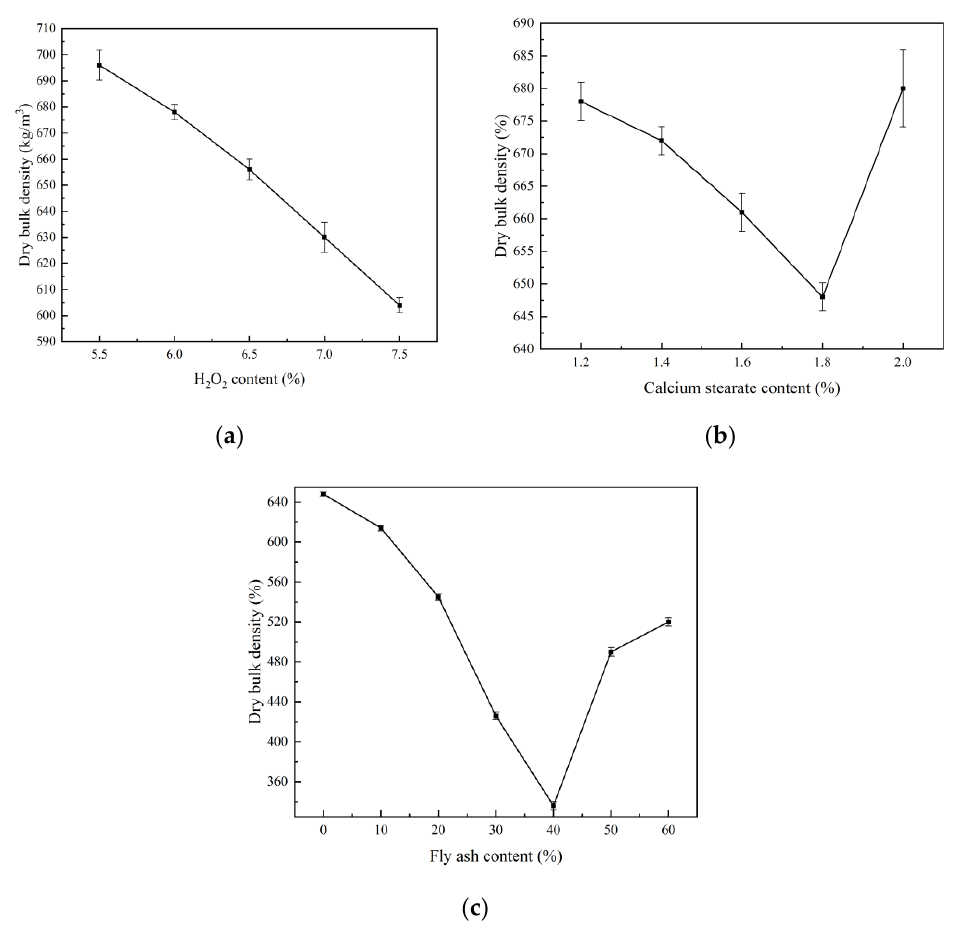
Figure 3. Dry bulk density of foamed concrete: ( a ) H 2 O 2 content; ( b ) calcium stearate content; ( c ) fly ash content.